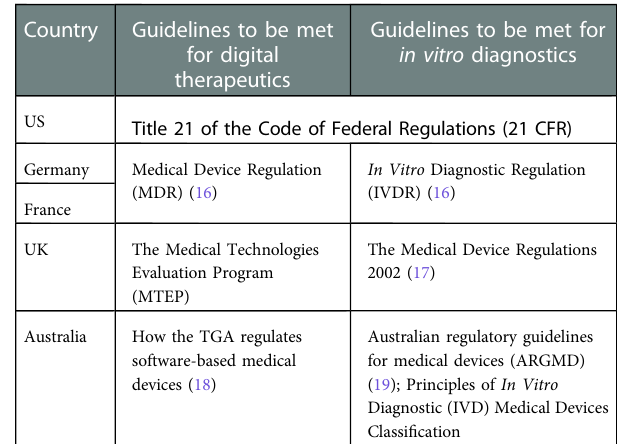
TABLE 2 Documents containing guidelines for the regulation of digital therapeutics and in vitro